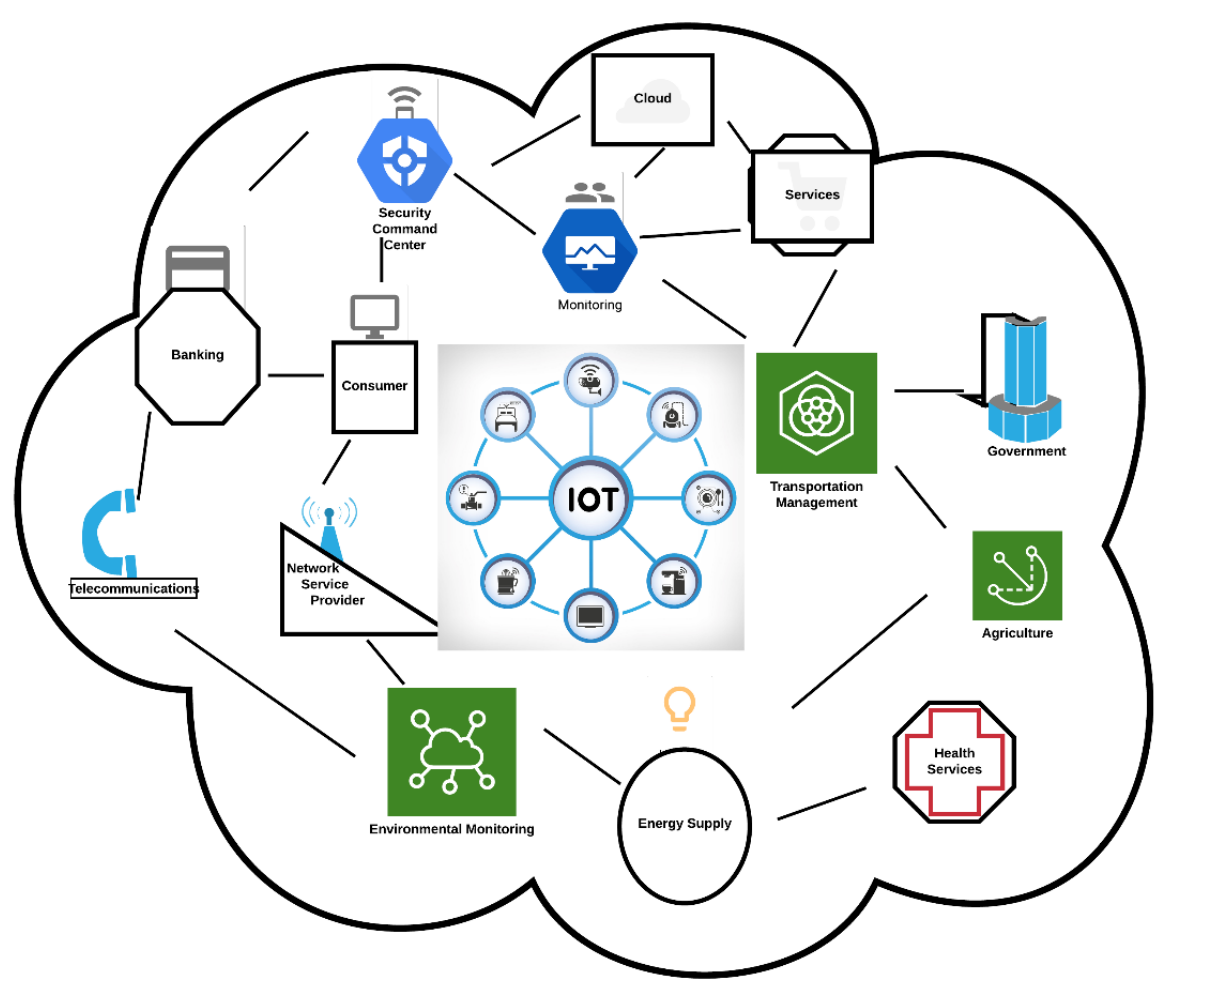
Figure 1. The Internet of